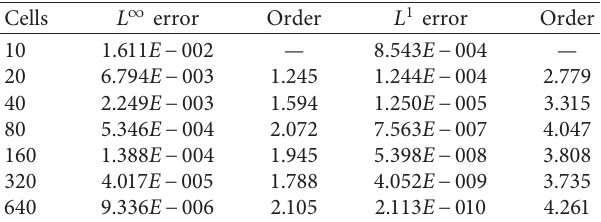
Table 1: Example 1, ε � 1, numerical errors and orders of con- vergence at t � 1.